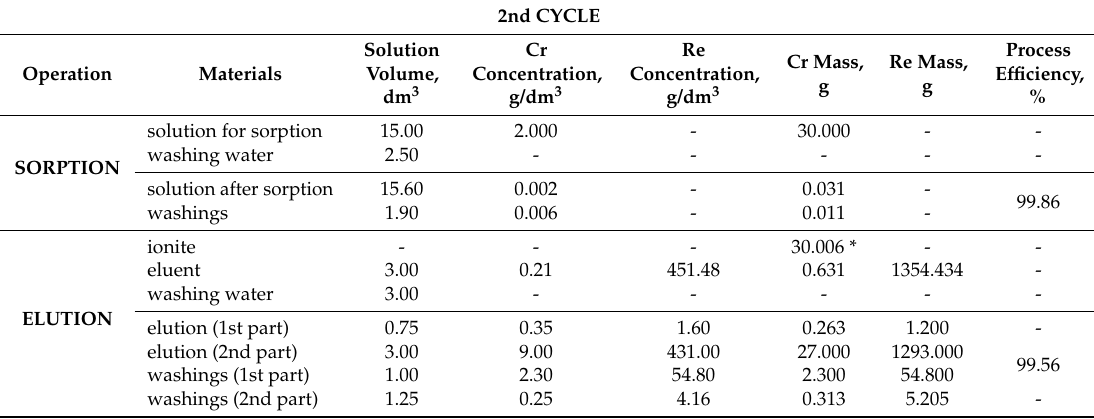
Table 2. Chromium(III) sorption and elution balance—2nd cycle. 2nd CYCLE